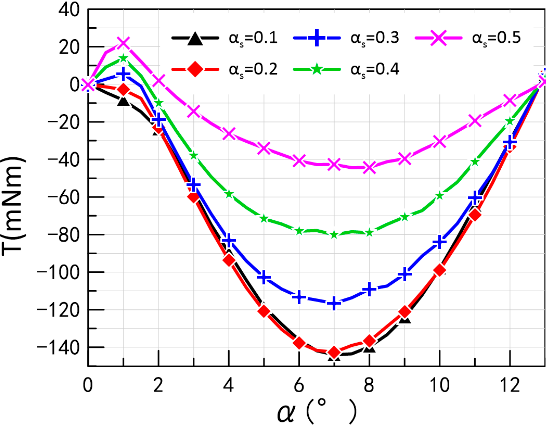
Figure 13. Cogging torque waveforms with different slot opening coefficients. It can be found that when the slot opening factor is 0.1 or 0.2, the phase of the cogging torque is negative. When the notch opening factor is greater than 0.3, there is a positive phase of the cogging torque.